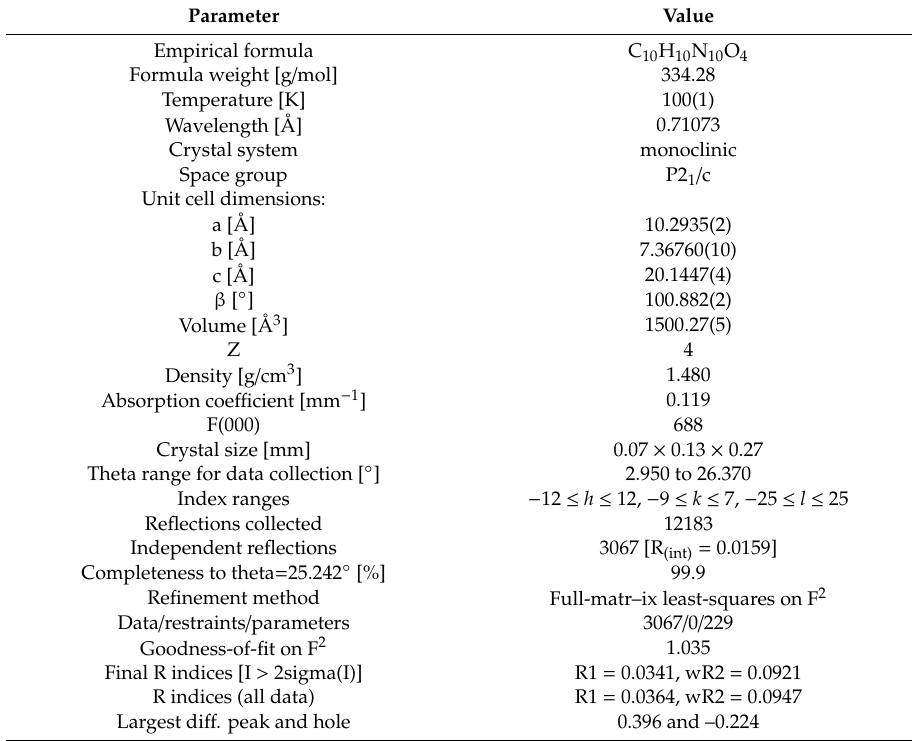
Table 1. Crystal data and structure refinement for TCAD·4H 2 O.